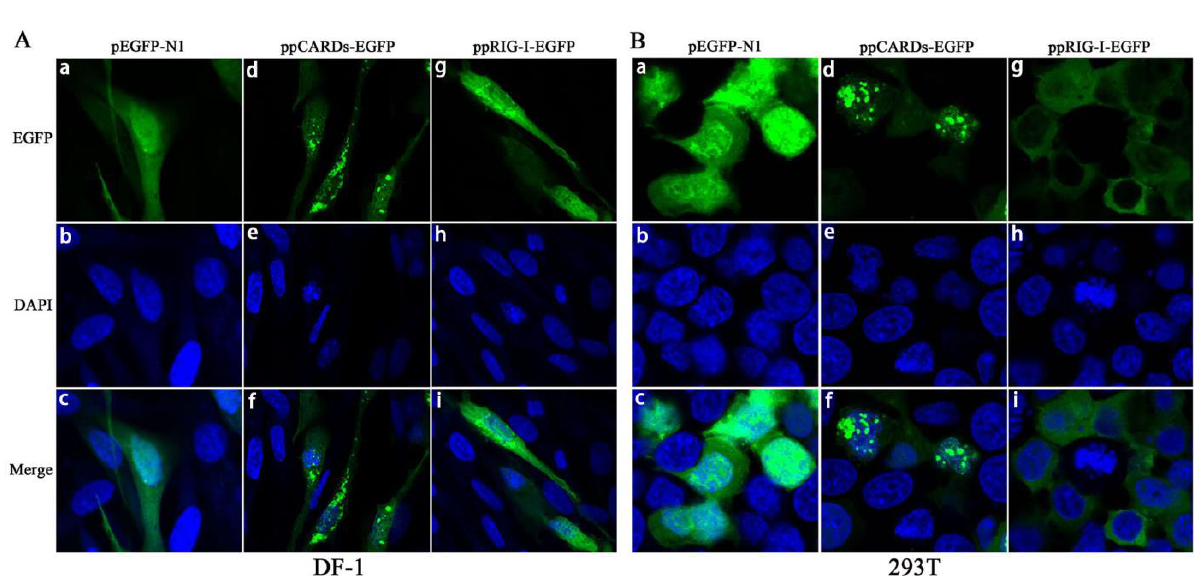
Localization of pigeon CARDs and RIG-I in chicken DF-1 cells and human 293T cells ( A ) DF-1 cells were transfected with pEGFP-N1, ppCARDs-EGFP (ppigeonCARDs-EGFP) and ppRIG-I-EGFP (ppigeonRIG-I-EGFP), and 24 h later, transfected cells were dyed with DAPI, then, the cellular localization of pRIG-I and CARDs was examined via confocal microscopy; ( B ) 293T cells were transfected with pEGFP-N1, ppCARDs-EGFP and ppRIG-I-EGFP, and 24 h later, the transfected cells were dyed with DAPI, then, the cellular localization of pRIG-I and CARDs was examined via confocal microscopy.